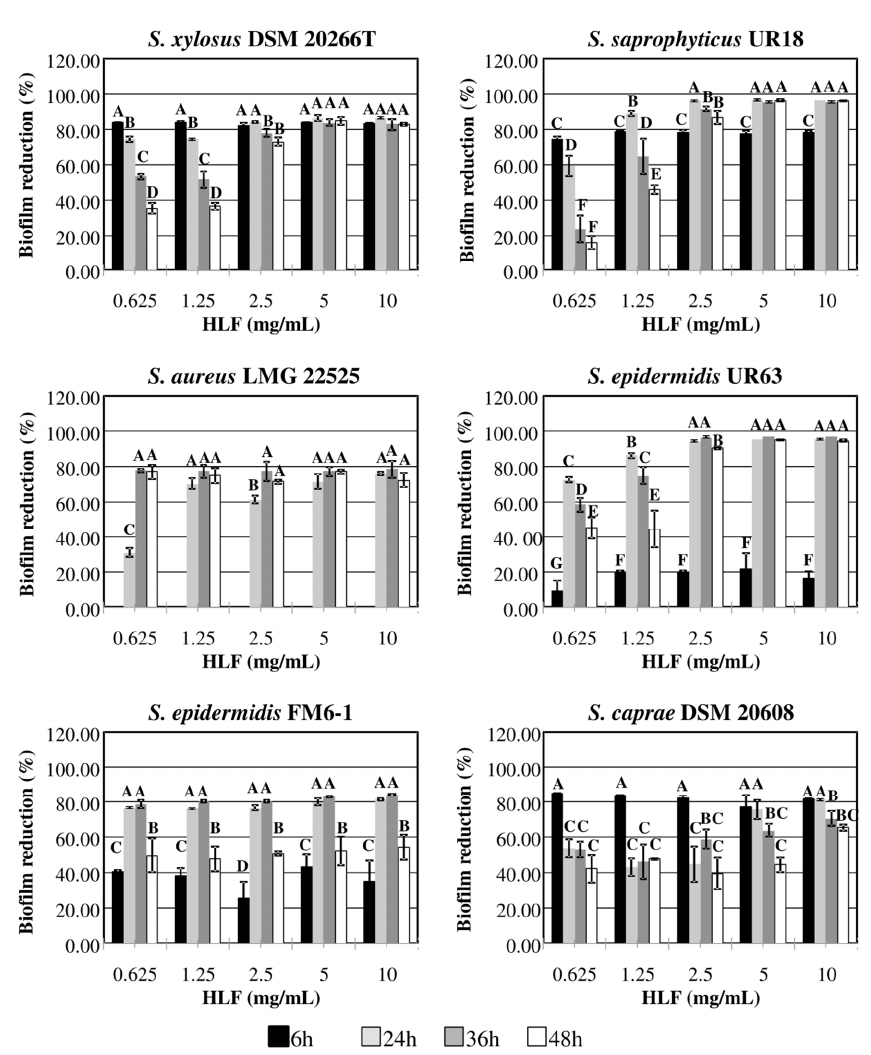
Figure 2. Biofilm reduction percentage (%) by HLF concentrations (0.625, 1.25, 2.5, 5, and 10 mg / mL) added in TSB broth inoculated with Staphylococcus spp. at 37 ◦ C and at di ff erent incubation times (6, 24, 36, 48 h). The letters above bars show homogeneous subgroups ( p > 0.05) based on Kruskal-Wallis analysis followed by Dunn’s post hoc tests ( n = 3). Line represents the calculated minimal biofilm inhibitory concentration (mg / mL; minimal biofilm inhibitory concentration